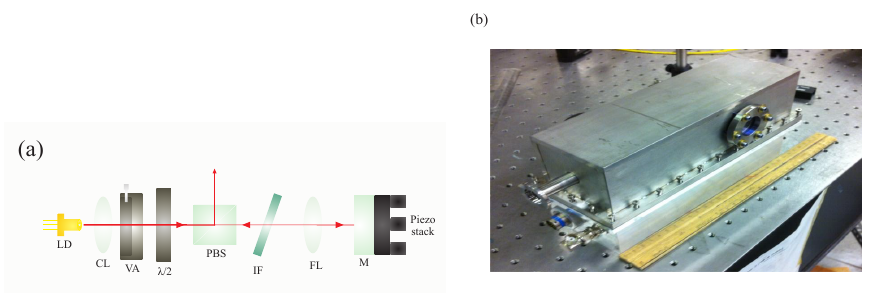
Figure 1. ( a ) Layout of IF laser. The optical elements are: LD—laser diode, CL—collimating lens, VA—variable aperture, λ /2—half wave-plate, PBS—polarizing beam splitter, IF—interference filter, FL—focusing lens, M—mirror. ( b ) Home-built IF-laser